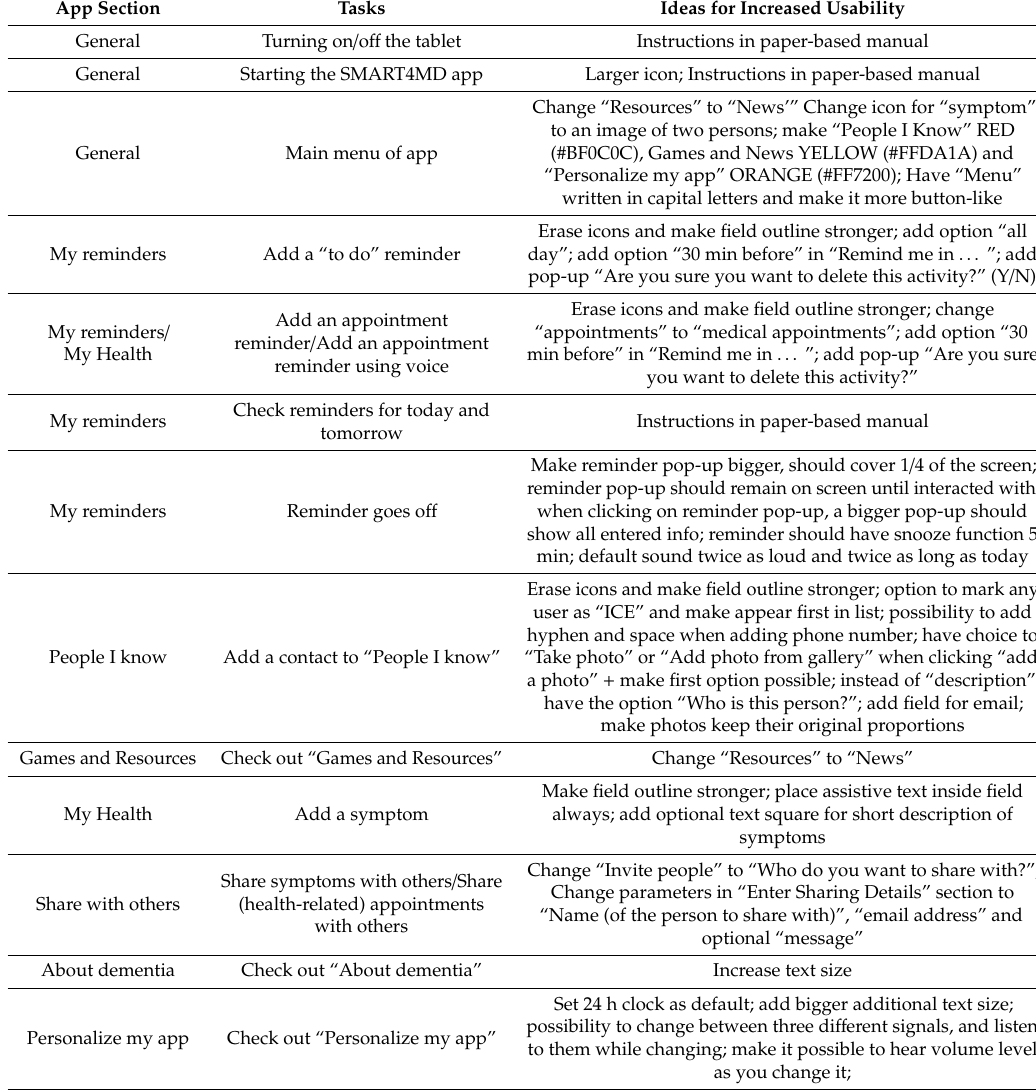
Table 5. Ideas for increased usability based on feedback from usability